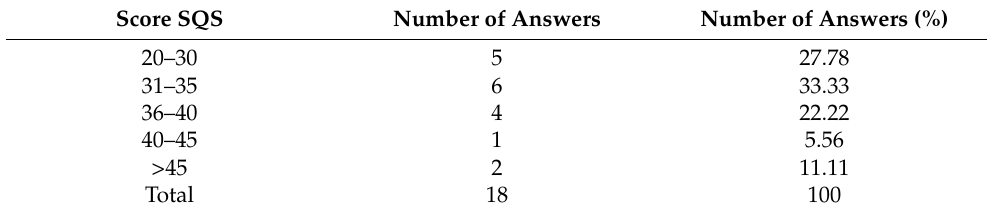
Table 3. Percentile repartition according to score intervals—SQS.